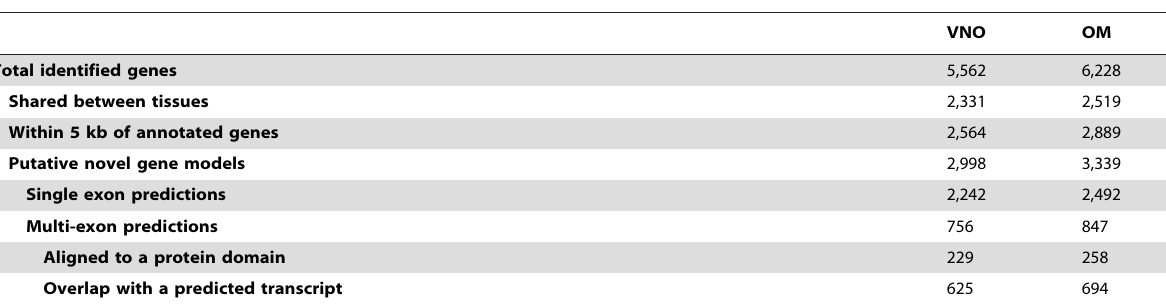
Table 2. Putative novel